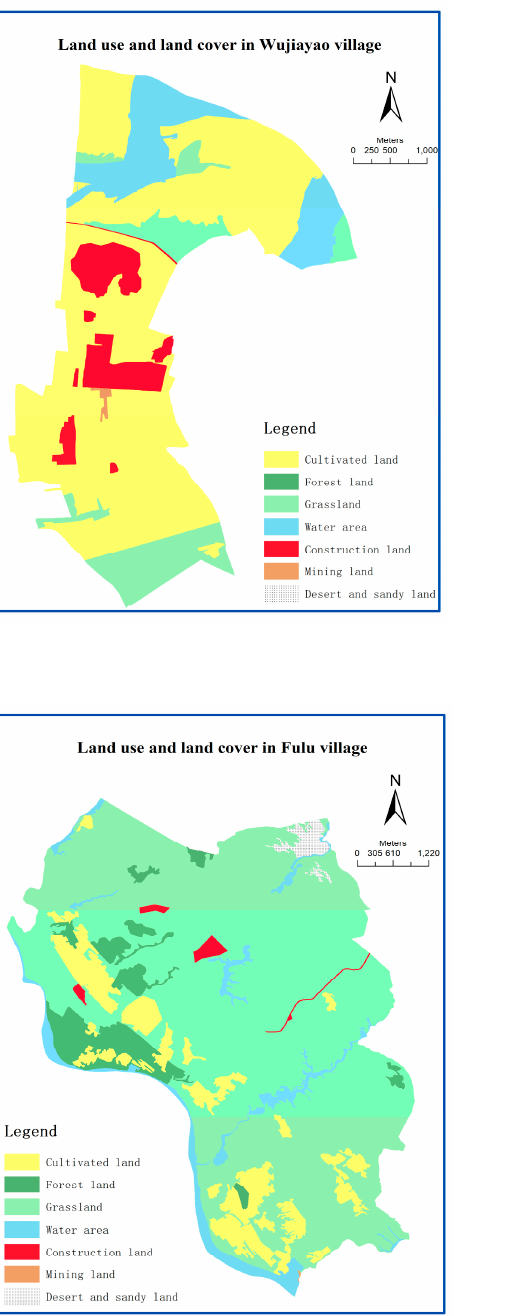
Figure 4. Land use patterns in four villages in 2015 (adopted from the Jungar Department of Natural Resources).